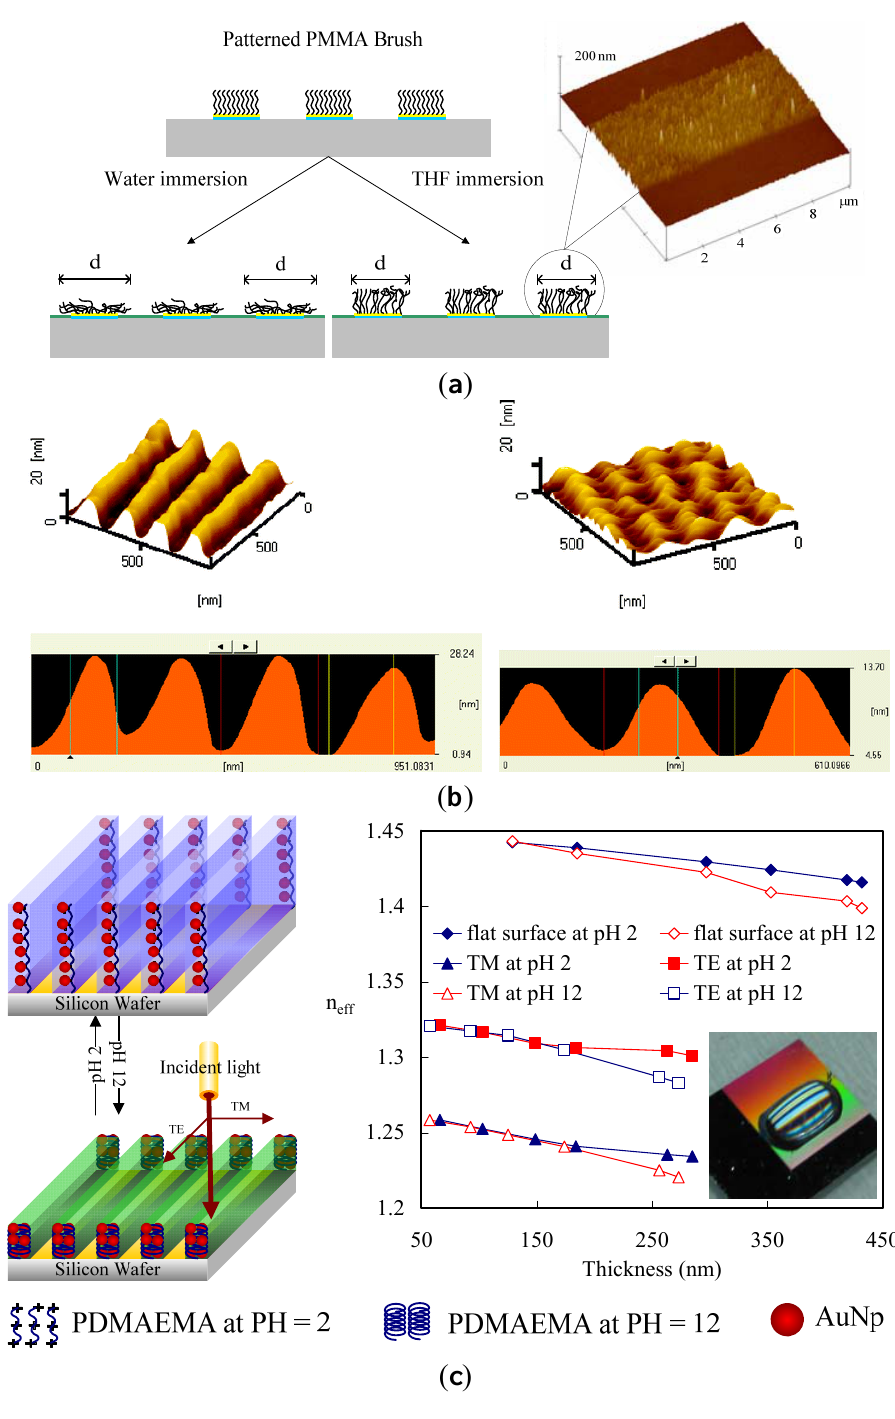
Figure 8. ( a ) Schematic illustrations of reversible poly(methyl methacrylate) (PMMA) brush treated with good and poor solvents; ( b ) Atomic force microscopy (AFM) images of densely patterned lines polystyrene (PS) brushes (1:1 duty ratio, 160 nm resolution) before and after good ( left ) and poor ( right ) solvent treatments, respectively; ( c ) Schematic of a polymeric sensor based on a surface-grafted polymer layer with AuNPs, adsorbed on a stimuli-responsive polymer line pattern grafted onto a silicon substrate. The AuNPs-surface distance depends on the conformation of the polymer chains and changes in different solvents. The change in height is therefore reported by a variation in the detected diffractive intensity. Reprinted from Reference [108,110,114] with